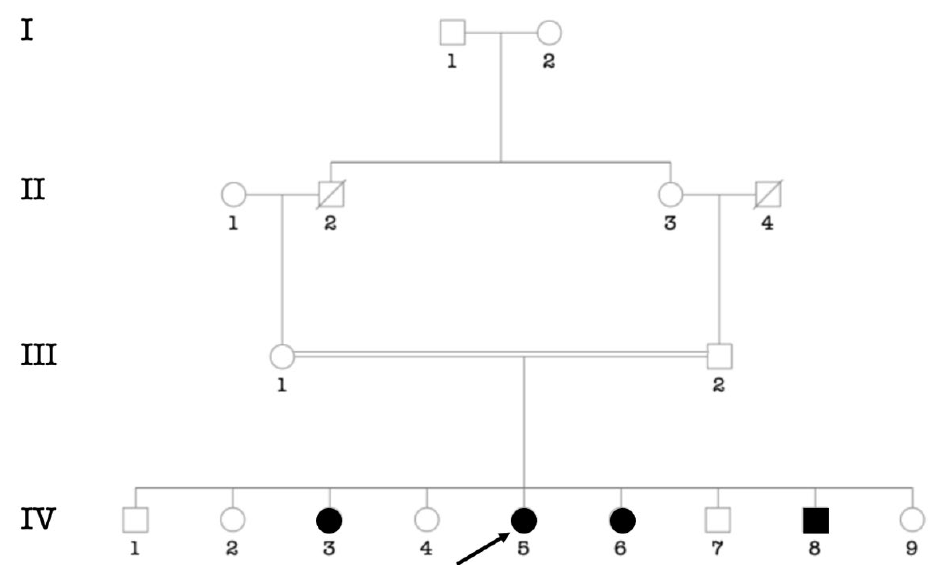
Figure 5. Pedigree showing four affected individuals from a consanguineous marriage segregating Pendred syndrome. The arrow indicates the proband.